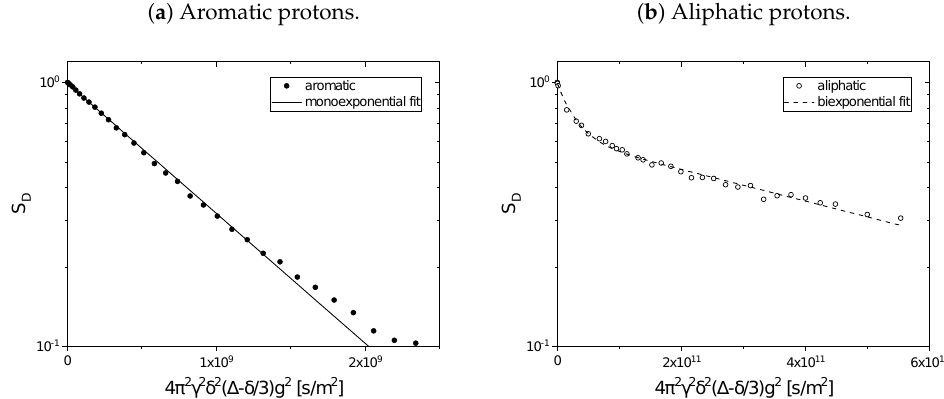
Figure 16. PGSTE signal decay of the aromatic ( a ) and aliphatic ( b ) protons in a solution of 150g/L asphaltene in benzene-d 6 . To obtain the signal decay of the aliphatic protons, the gradient strength was varied up to